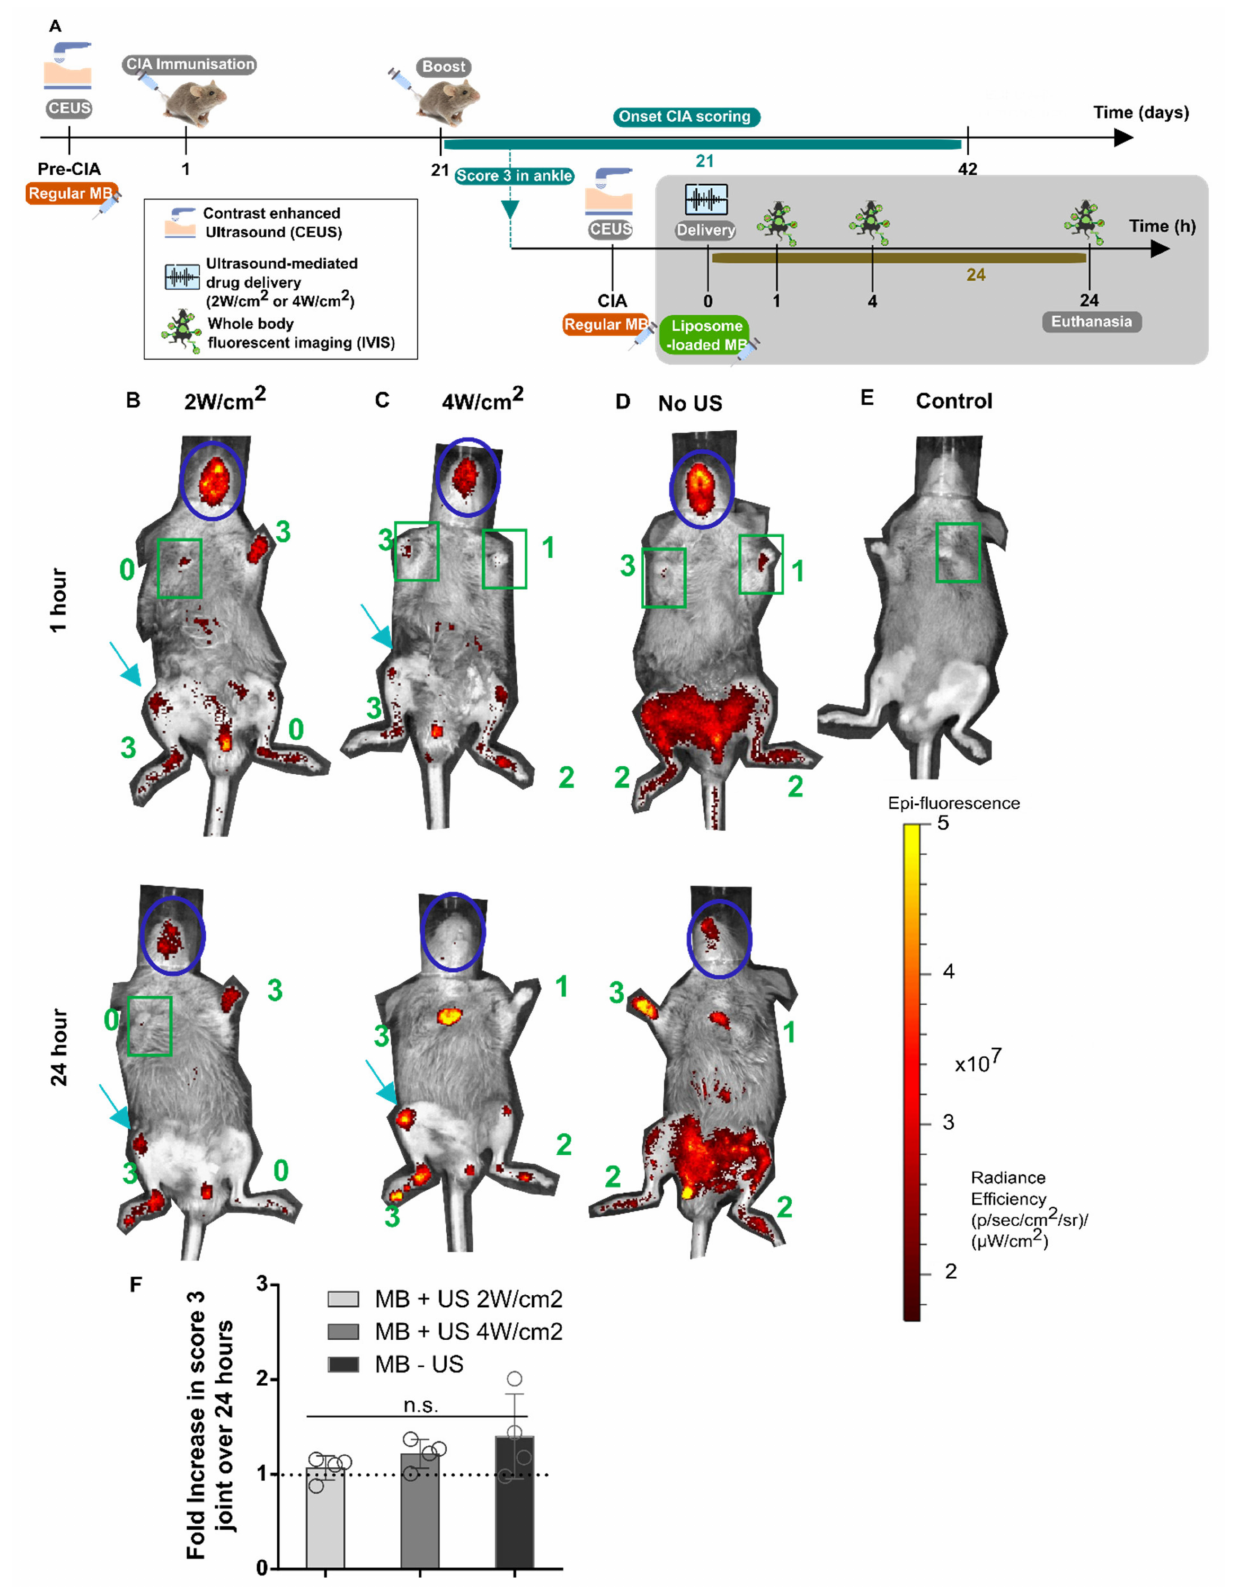
Figure 3. Whole-body fluorescence images to illustrate the bio-distribution of fluorescently labelled liposomes. ( A ) Timeline of the whole experimental study. The therapeutic study is indicated by the grey box: after the second CEUS imaging, mice were i.v. injected with liposome-loaded microbubbles and the knee of mice with a visual score 3 in the ankle joints were exposed to a therapeutic